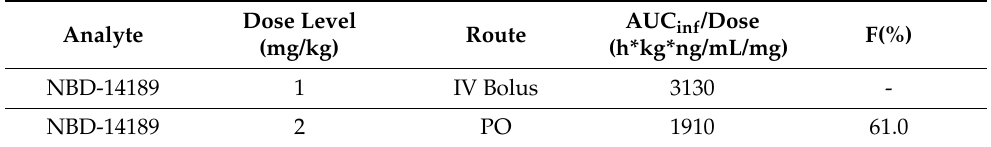
Table 3. Bioavailability of NBD-14189 following a single IV bolus or PO administration in male Beagle Dogs.